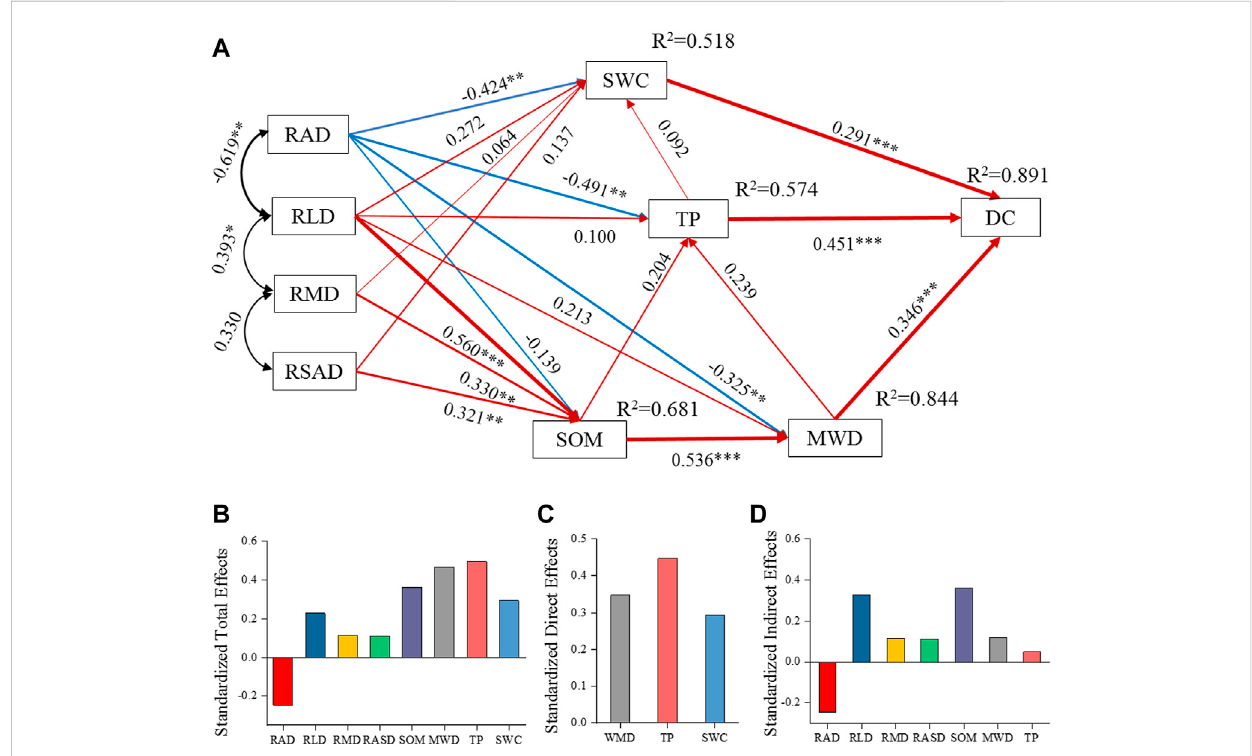
FIGURE 6 analysisoftheeffectsofrootandsoilpropertiesonDC. χ 2 =11.838, χ 2 /df=0.789, p =0.691 > 0.05,CFI=1,RMSEA=0.000,AIC=71.838. R 2 indicates the proportion of variance explained by each variable. Single arrowheads indicate causality; double arrowheads indicate correlations; red indicates a positive effect and blue a negative effect; arrowhead thickness represents the value of the path coef fi cient. (A) Structural equation model; (B) standardized total effects; (C) standardized direct effects; (D) standardized indirect effects. All abbreviations are de fi ned in Figure